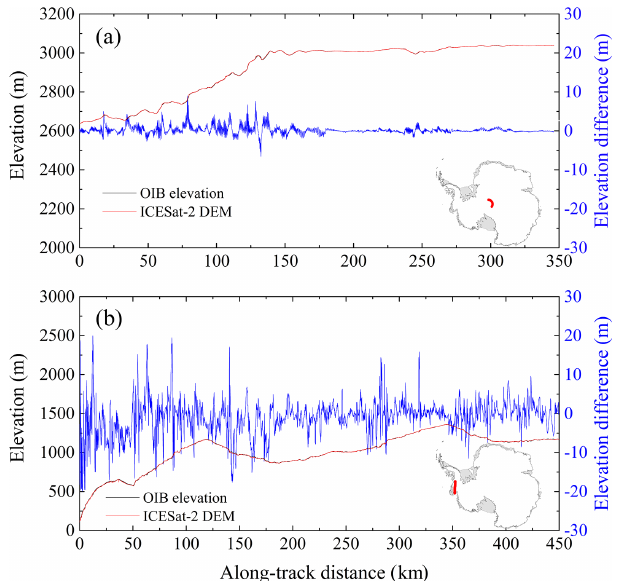
Figure 10. Differences between the ICESat-2 DEM and OIB eleva- tions along two OIB flight paths in (a) ice sheet interior and (b) Pine Island Glacier. ICESat-2 DEM elevations are in red, OIB elevations are in black, and the elevation differences between ICESat-2 DEM and OIB elevations are in blue. Locations of the two OIB flight paths are shown in red in the inserted figures of